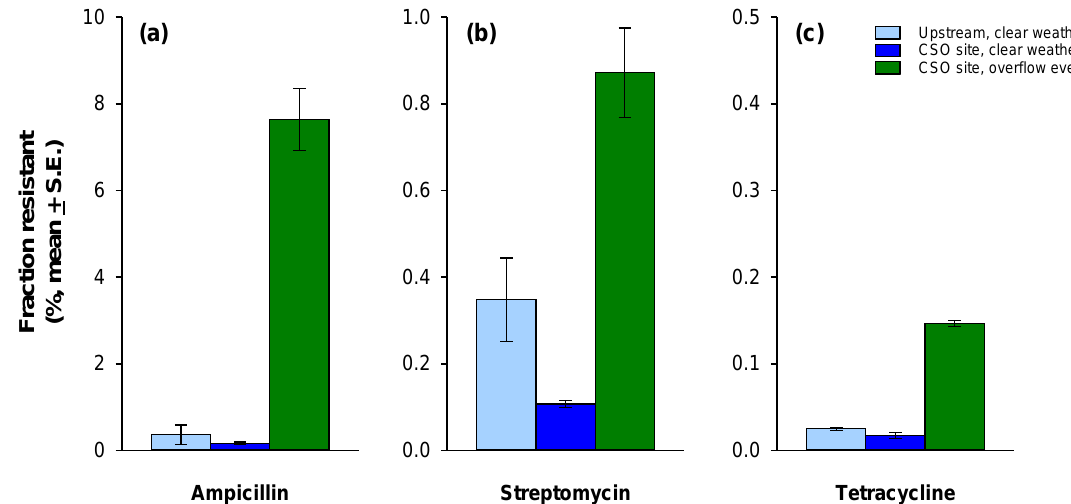
Figure 2. Samples collected from the upstream site during clear weather (left bar, light blue), the CSO-impacted site during clear weather (center bar, dark blue), and the CSO-impacted site during an overflow event (right bar, green) were analyzed to determine the fraction of the culturable bacterial community resistant to either: ( a ) ampicillin, ( b ) streptomycin, or ( c ) tetracycline. Note the difference in scale on the y -axis.